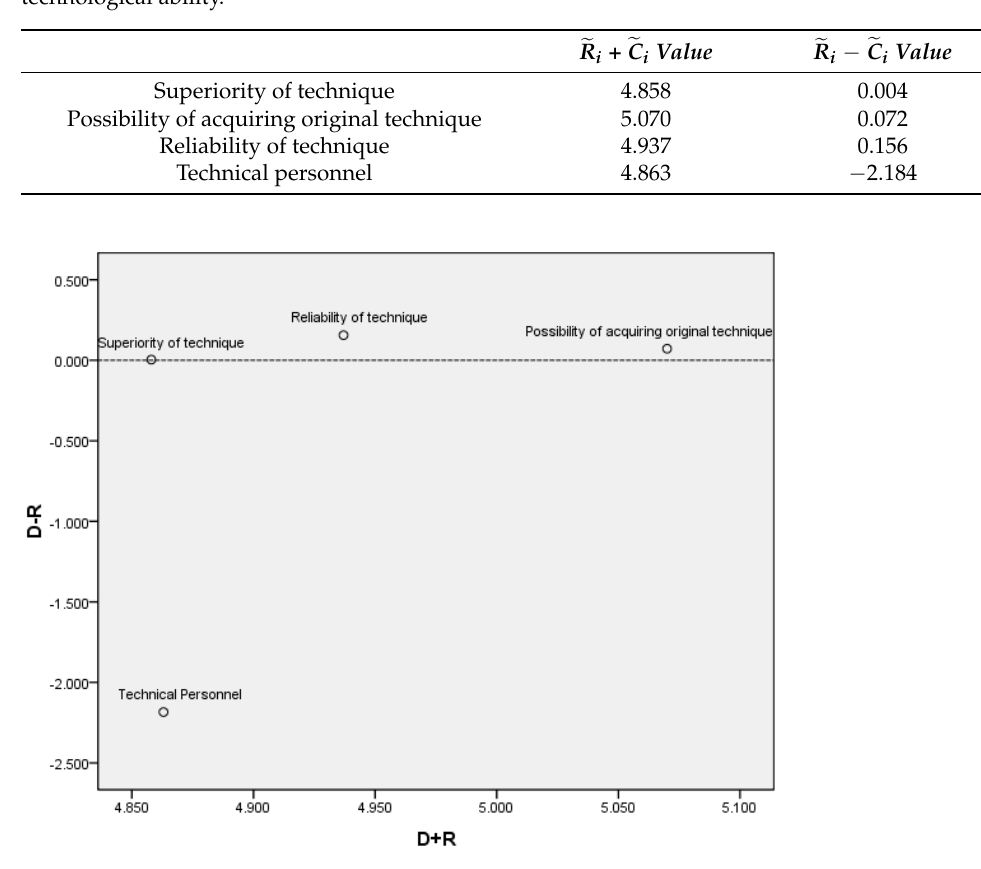
Figure 4. Graph of appearing causal relationship of the technological ability criteria.